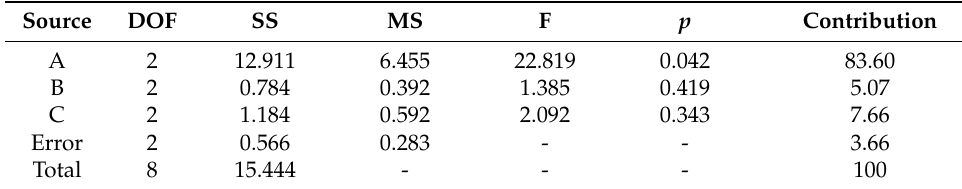
Figure 12. FEM results for warpage. Table 9. ANOVA table for FEM predicted H.